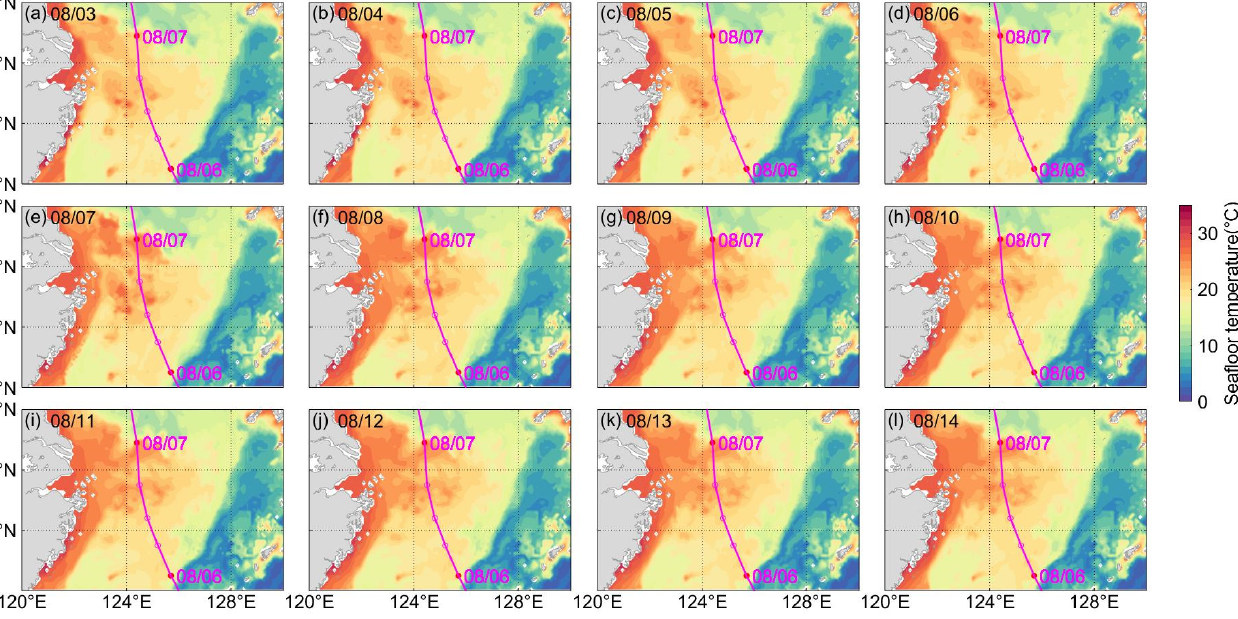
Figure 5. Same as Figure 4 but for seafloor temperature. Seafloor temperature at 00:00 on ( a ) 3, ( b ) 4, ( c ) 5, ( d ) 6, ( e ) 7, ( f ) 8, ( g ) 9,( h ) 10, ( i ) 11, ( j ) 12, ( k ) 13 and ( l ) 14